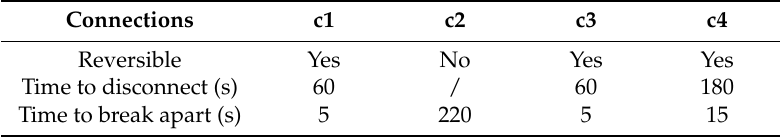
Table 4. Values for the connections between elements in the (fictive) façade wall example. These values were arbitrary chosen to illustrate the principle behind the DNA method. c1 c2 c3 c4 Yes